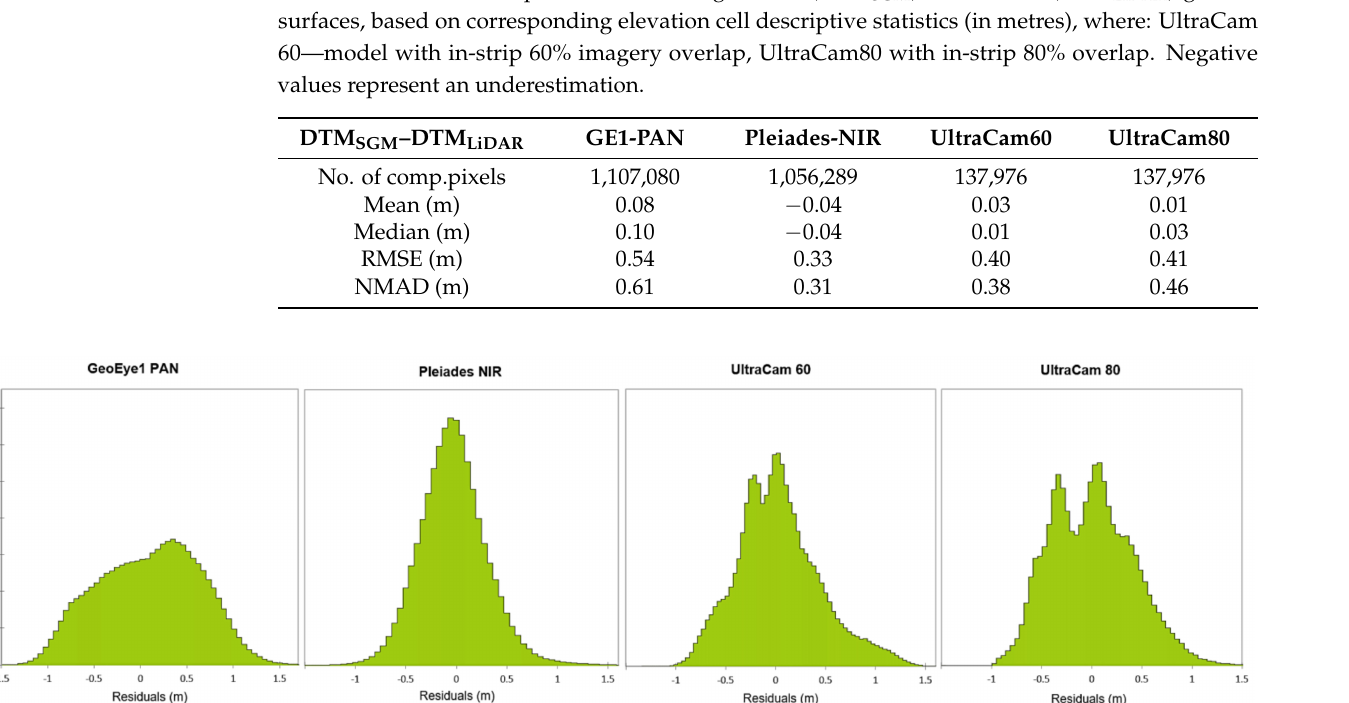
Table 4. Pixel-wise comparison of the image-based (DTM SGM ) and LiDAR (DTM LiDAR )-ground surfaces, based on corresponding elevation cell descriptive statistics (in metres), where: UltraCam